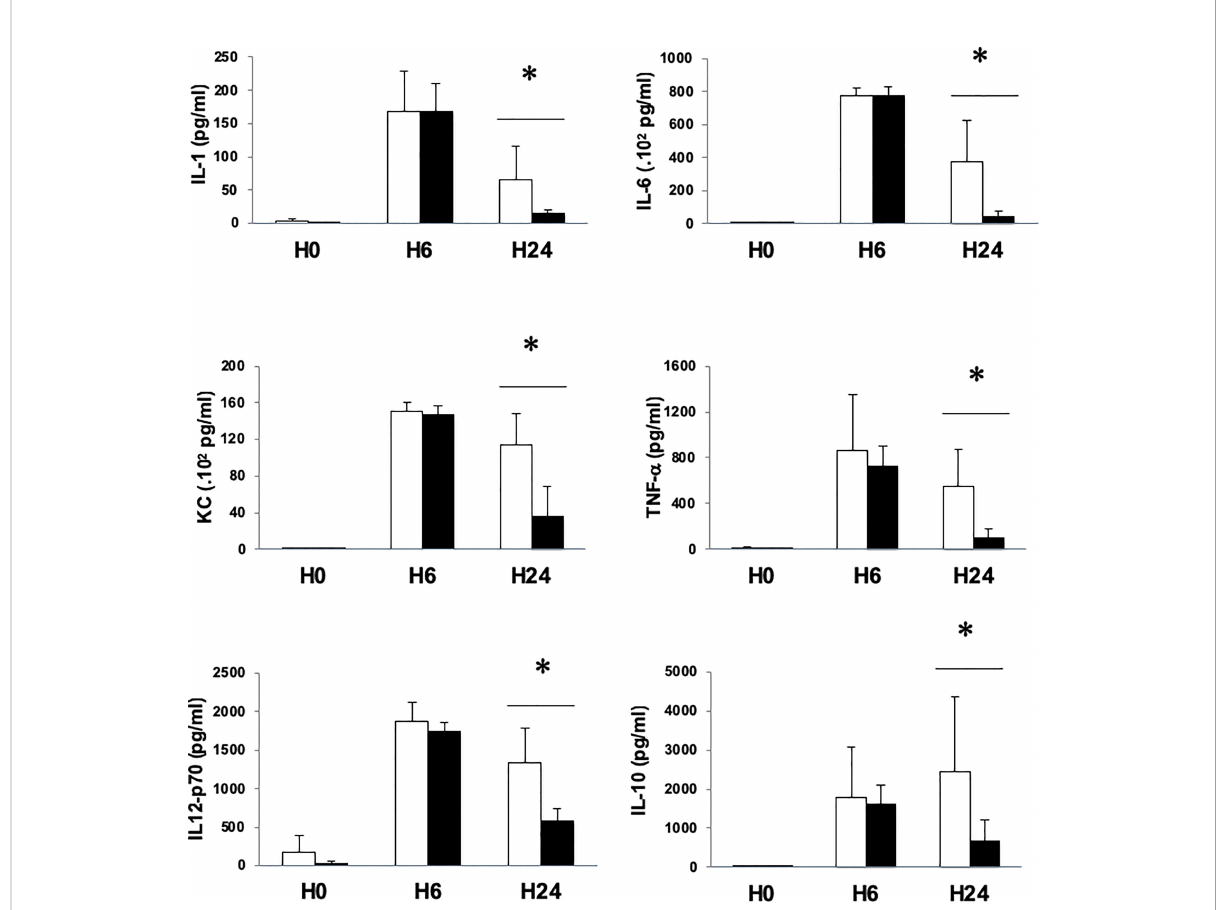
FIGURE 4 MMF treatment attenuates the release of pro-in fl ammatory and anti-in fl ammatory cytokines during infection with S. aureus . Mice were treated with MMF, which started one day before i.p. injection of 10 8 CFU S. aureus (black histograms) and were compared to control mice treated with an equivalent volume of NaCl 0.9% (white histograms). Mice were euthanized 6 (n=5 in each group) and 24 hours (n=10 in each group) after infection. Serum IL-1, IL-6, KC, TNF, IL12p70 and IL-10 were measured by Mesoscale Discovery technology. Data are represented as means ± SD. Differences were calculated using Student ’ s t test. * P